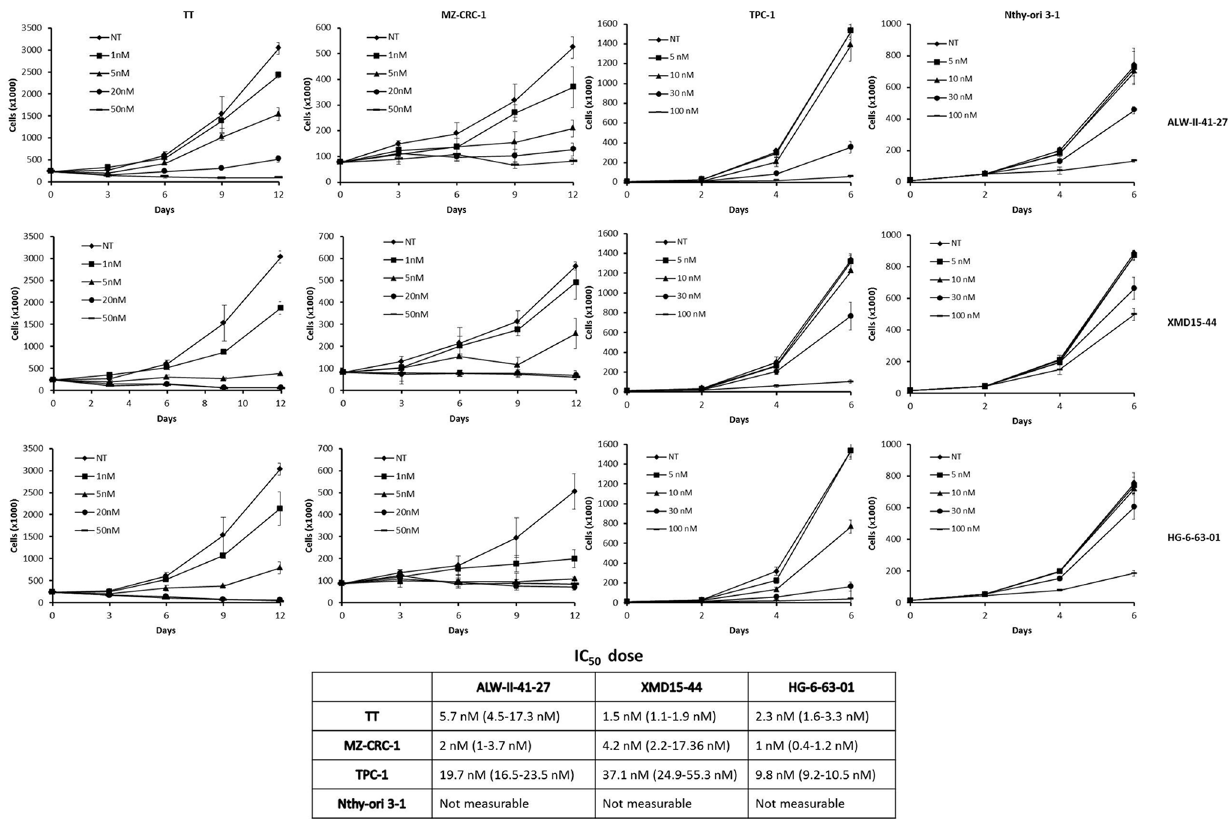
Fig 5. ALW-II-41-27, XMD15-44 and HG-6-63-01-mediated inhibition of proliferation of RET mutant thyroid carcinoma cell lines. Top) TT, MZ-CRC-1, TPC1 and Nthy-ori-3-1 cell lines were incubated with vehicle (NT: not treated) or the indicated concentrations of ALW-II-41-27, XMD15-44 and HG-6-63-01 and counted at the indicated time points. Data are the mean ± SD of two experiments performed in triplicate. Bottom) Growth inhibition IC 50 of ALW-II-41-27, XMD15-44 and HG-6-63-01 for the different cell lines: 95% CI are indicated in